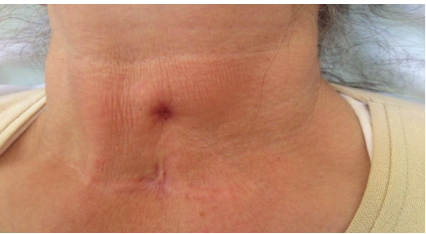
Figure 1: Cutaneous sinus located superior to the thyroidectomy incision.